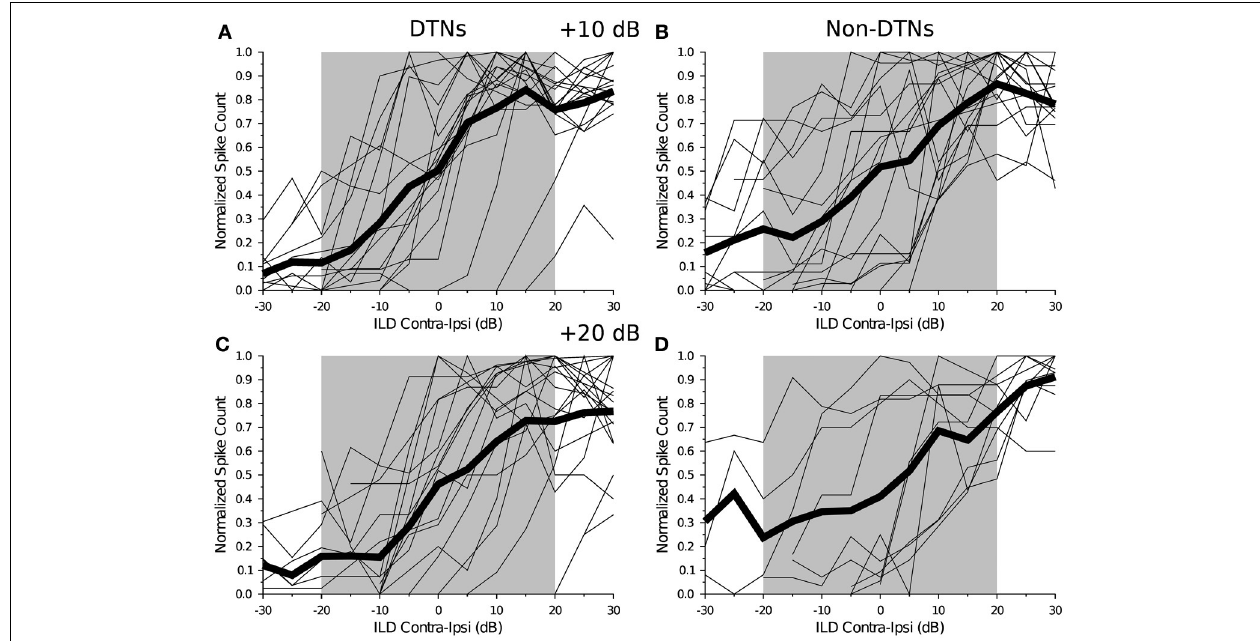
FIGURE 2 | Individual and population average monotonic ILD response functions for DTNs and non-DTNs from the IC of the big brown bat. Each panel shows the normalized ILD response curves for individual neurons ( thin black lines ) as a function of ILD, measured in dB as the SPL in the contralateral ear minus the SPL in the ipsilateral ear, while the bold black line is the population average. The gray region is a conservative estimate of the biologically relevant range of dominant ILD cues for an adult Eptesicus fuscus . During data collection, the SPL presented to the contralateral ear was held constant while the SPL presented to the ipsilateral ear was varied in 5dB steps from − 30dB to + 30dB re